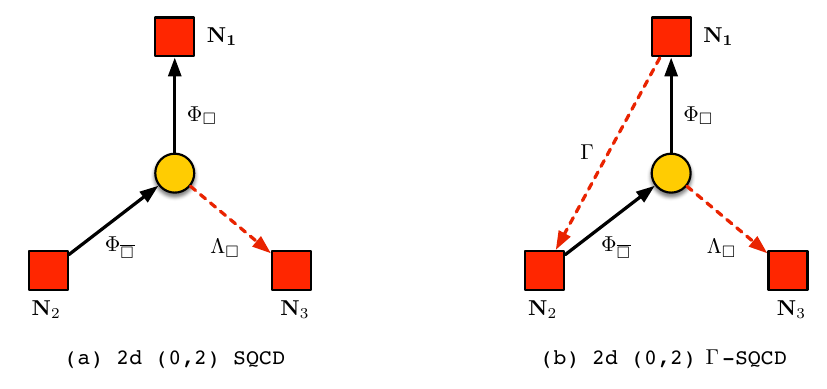
SQCD. The fermi (cid:12)elds (cid:10) (cid:0)